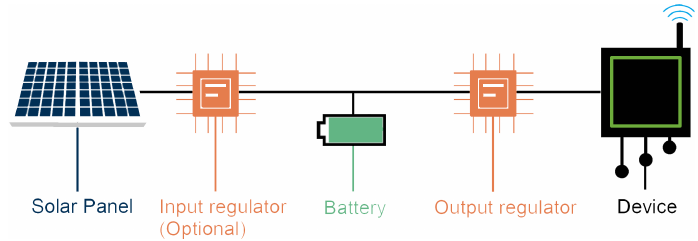
Figure 1. System